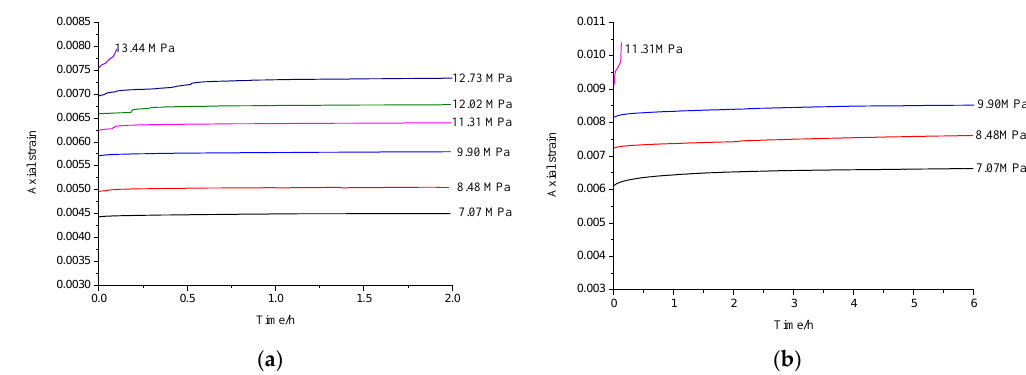
Figure 10. Typical creep curves of sandstone-coal composite samples: ( a ) Creep curve of A-1 composite sample; ( b ) Creep